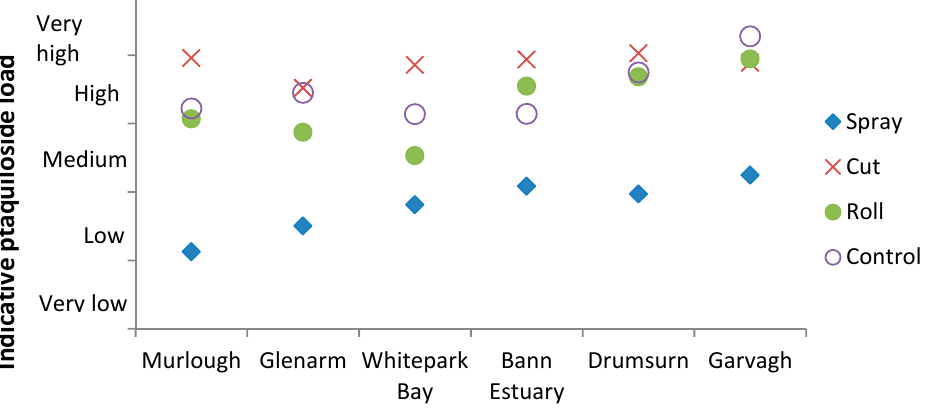
Figure 8. Effect of treatment regime on ptaquiloside load for the 6 experimental sites in Northern Ireland, UK.